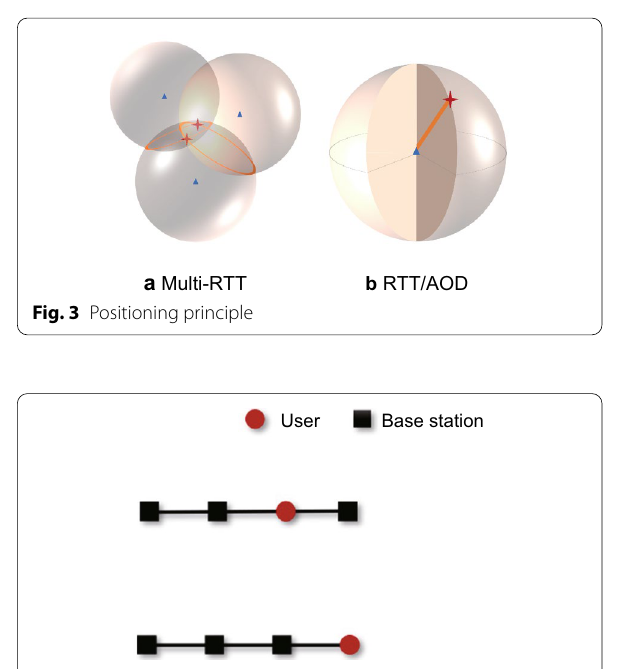
Fig. 4 Worst distribution of three base stations